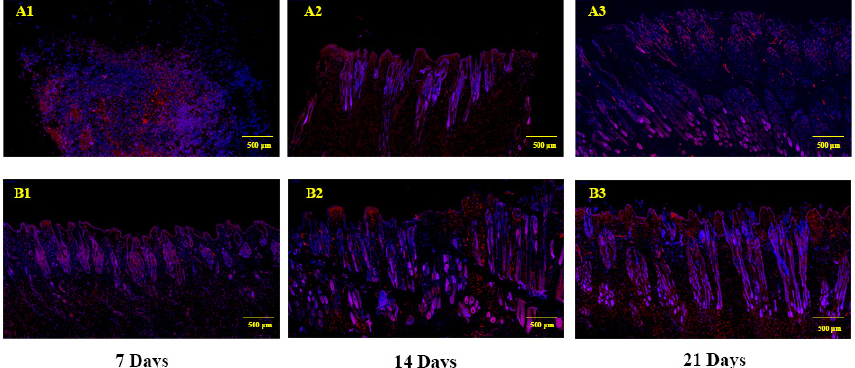
Figure 6. Immunofluorescence analysis of sequential skin samples. ( A1 – A3 ) Control group at 7, 14 and 21 days. ( B1 – B3 ) Combined treatment group at 7, 14 and 21 days. Red indicates PCNA staining, blue indicates DAPI (nuclear) staining.